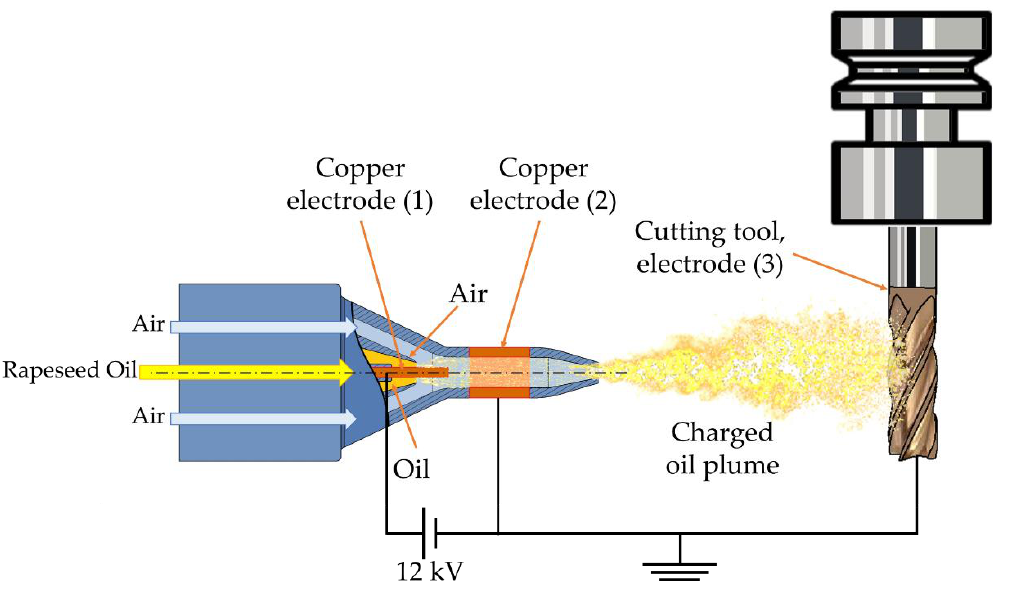
Figure 1. Schematic of Electrohydrodynamic Atomization Minimum Quantity Lubrication (EHDA-MQL) nozzle and machining setup (not to scale).